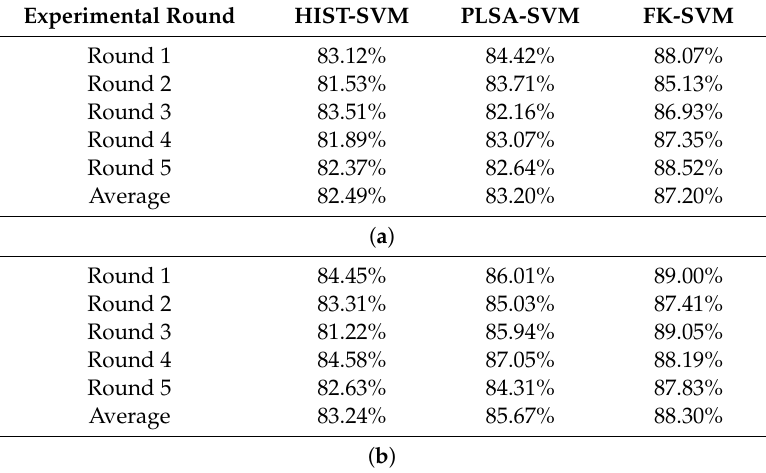
Table 1. The multi round compared experimental results of FK-SVM, HIST-SVM and PLSA-SVM. ( a ) Precision. ( b ) Recall